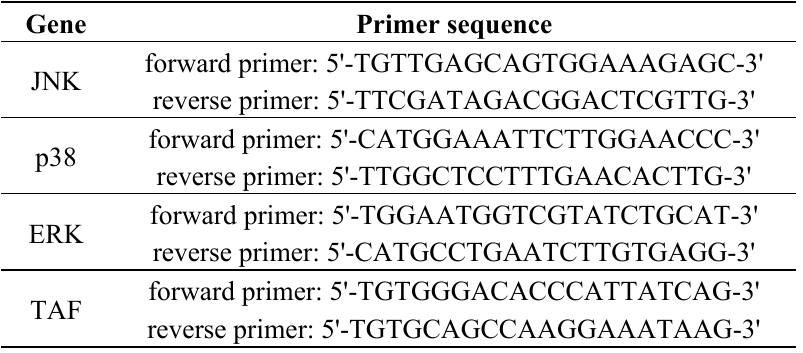
Table 1. List of qRT-PCR primers